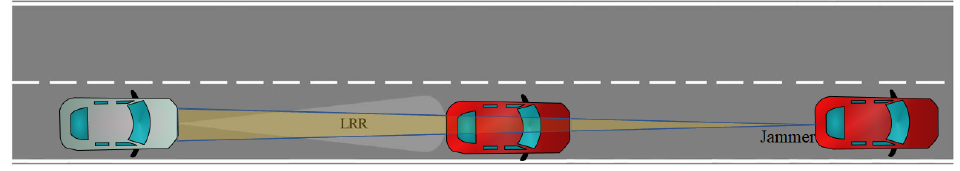
Figure 4. Scenario-4. An RVGPO/I technique for spoofing the real automobile echo.